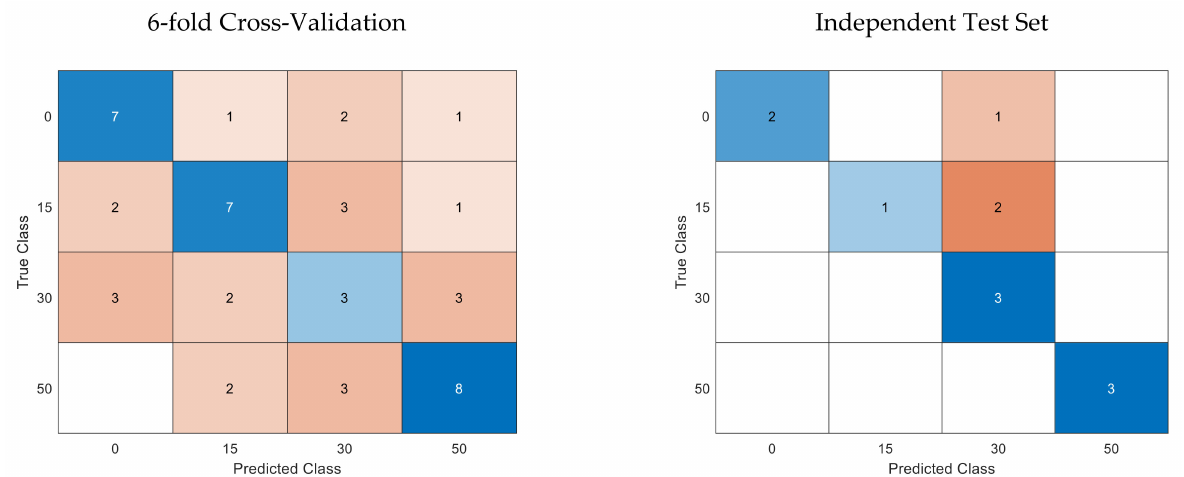
Figure 3. Confusion matrices of the 6-fold cross-validation set and independent test set. On the diagonal are reported the true positive and true negative cases for each class. Along the rows there are false negative cases and along the column are reported the false positive cases.